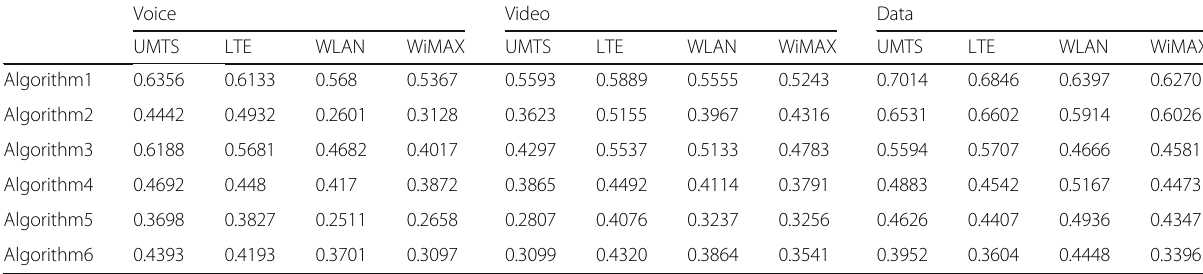
Table 22 Average scores of candidate networks for different algorithms for different applications